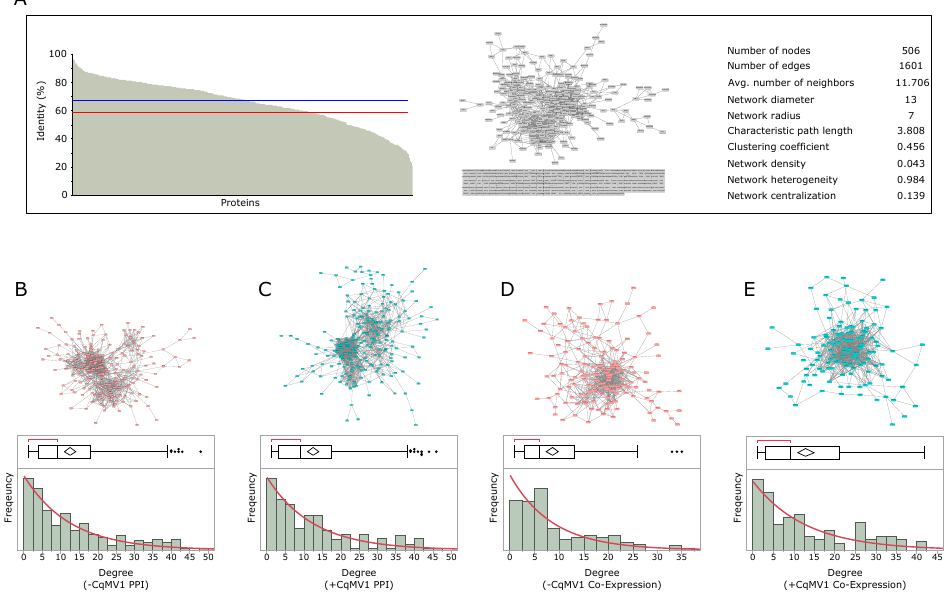
Figure 4. Chenopodium quinoa protein–protein interaction (PPI) and co-expression network recon- struction. ( A ) Sequence homology between mitochondrial predicted/annotated Chenopodium quinoa proteins and Arabidopsis thaliana ( n = 506); red line indicates the average sequence homology (58%), while blue line indicates median (67.5%). Using exclusively predicted or/and annotated mito- chondrial proteins, a PPI model of 506 nodes and 1601 edges was reconstructed by STRING (only experiments’ (score ≥ 0.15) or databases’ (score ≥ 0.35) annotated interactions were considered). Network topological parameters, by Cytoscape 3.8.2 NetworkAnalyzer, are shown. PPI network and degree distribution in ( B ) − CqMV1 and ( C ) +CqMV1 quinoa. Co-expression networks and degree distribution in ( D ) − CqMV1 and ( E ) +CqMV1